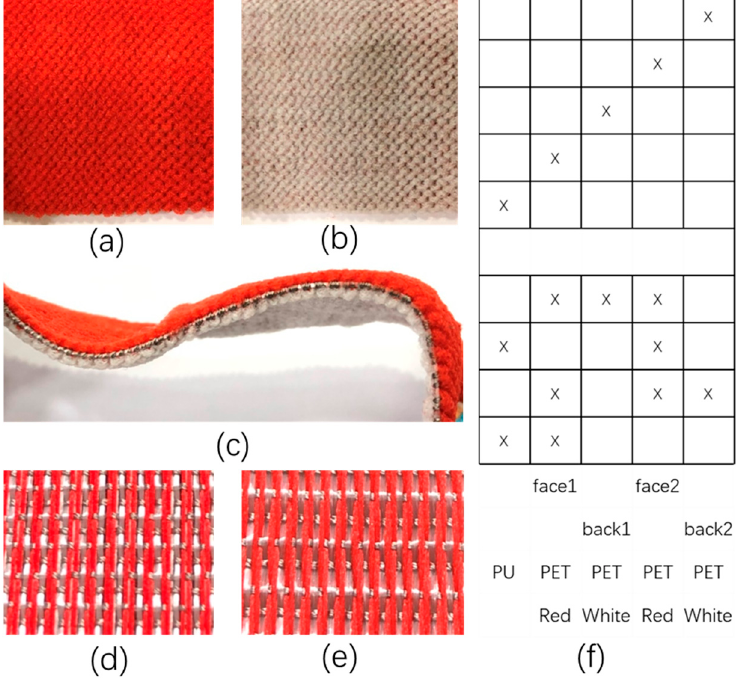
Figure 6. ( a ) The face view of the 3DWE-TENG with the electrode as the weft yarn; ( b ) The back view of the 3DWE-TENG with the electrode as the weft yarn; ( c ) The side view of the 3DWE-TENG with the electrode as the weft yarn; ( d ) 3DWE-TENGs with a warp yarn density of 417 ends/10cm in a stretch state; ( e ) 3DWE-TENGs with a warp yarn density of 533 ends/10 cm in a stretch state; ( f ) The stitching double weave diagram of the 3DWE-TENG with the electrode as the weft yarn.